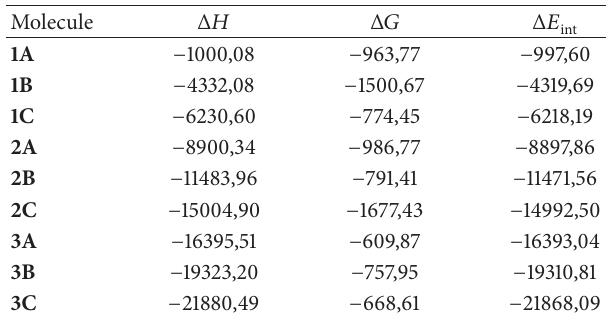
Table 1: Energies (Hartree) of the compounds related to their multiplicities obtained from B3LYP/6-31G(d)(Fe)U6-31+G(d,p)(E). Spin multiplicity